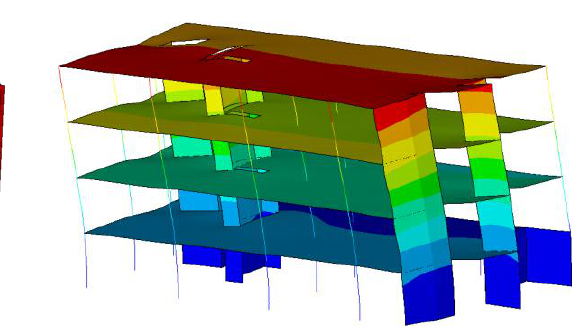
Fig. 4. 3D FE model of the Charles Institute frame. Fig. 5. Global sway mode of structure at